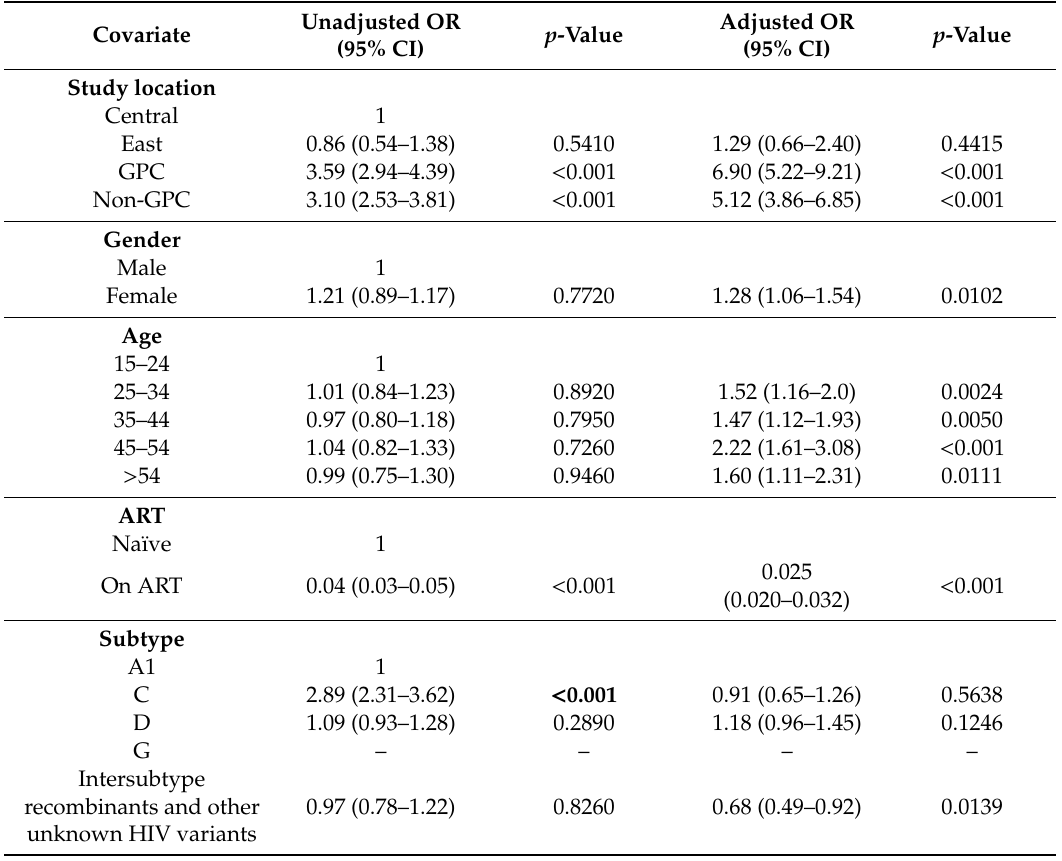
Table 5. Factors associated with the probability of belonging to a transmission